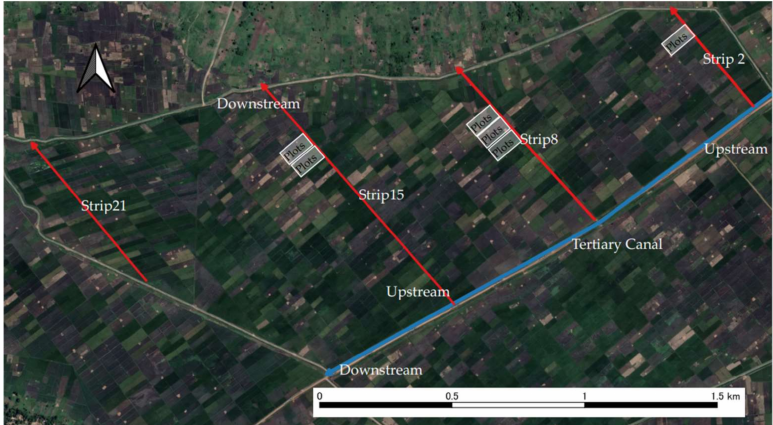
Figure 3. Canal maps of block 3 in